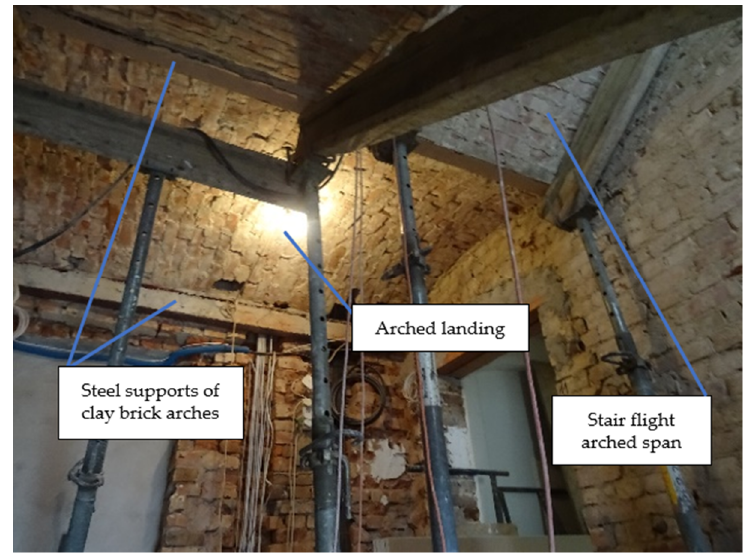
Figure 5. View of the researched masonry staircase.